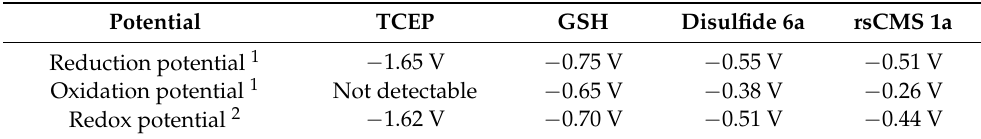
fide 6a and rsCMS 1a